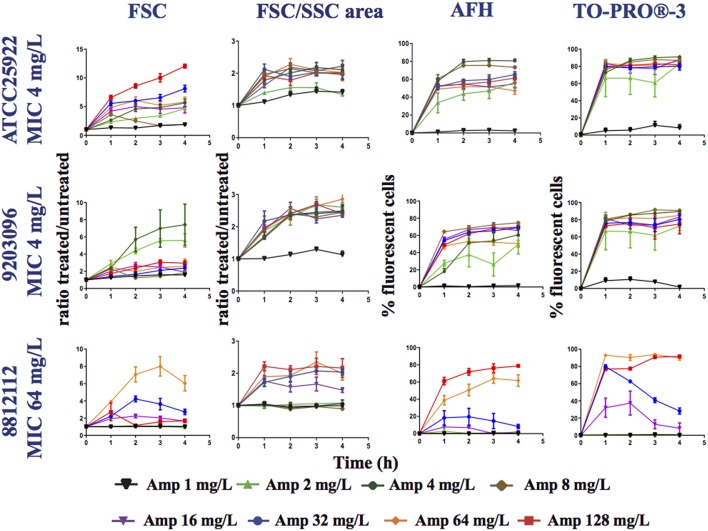
Monitoring alterations of the E. coli strains treated with a range of ampicillin concentrations via flow cytometry. The E. coli 7705035 (MIC = 4 mg/ml), 9203096 (MIC = 4 mg/ml), and 8812112 (MIC = 64 mg/ml) strains were treated with a range of ampicillin concentrations (0, 1, 2, 4, 8, 16, 32, and 64 mg/L). This figure shows the ratios of the mean FSC intensity of the ampicillin treated samples/the mean FSC intensity of the untreated samples, the ratios of the FSC/SSC area of the ampicillin treated samples/the FSC/SSC area of the untreated samples and the percentage of fluorescent cells stained with AFH and TO-PRO®-3, all relative to incubation time. Each value represents the mean value obtained from four independent experiments. The error bars correspond to the standard error of the mean.